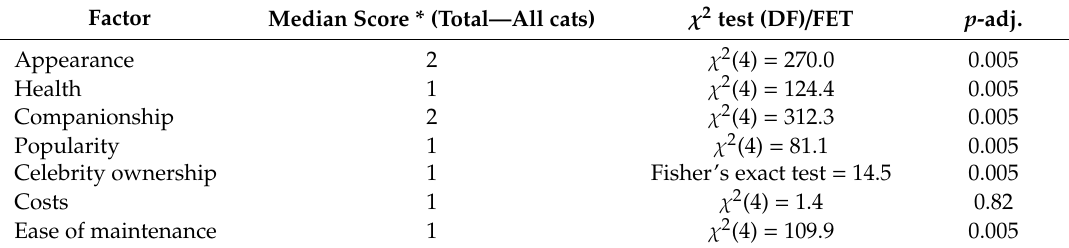
Table 5. (a) Analysis of influencing factors in cat acquisition. (b) Influencing factors in cat acquisition by cat type.